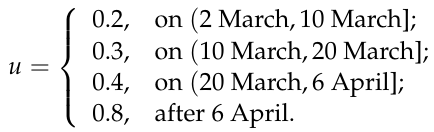
12 of 17 Table 1. Parameter values of models (1) and (4). Parameter